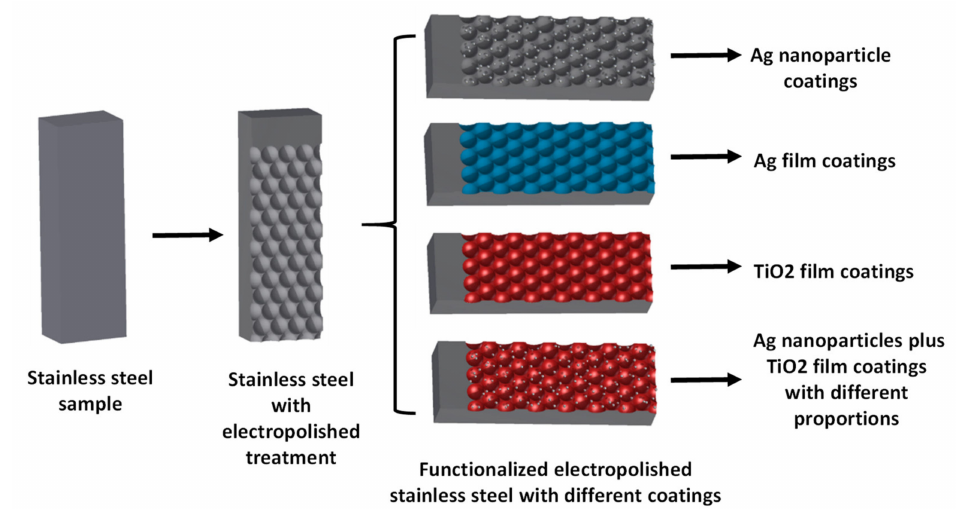
Figure 2. Schematic description of the nanostructuring and functionalization procedure performed on starting 316L food-grade stainless steel. Image is